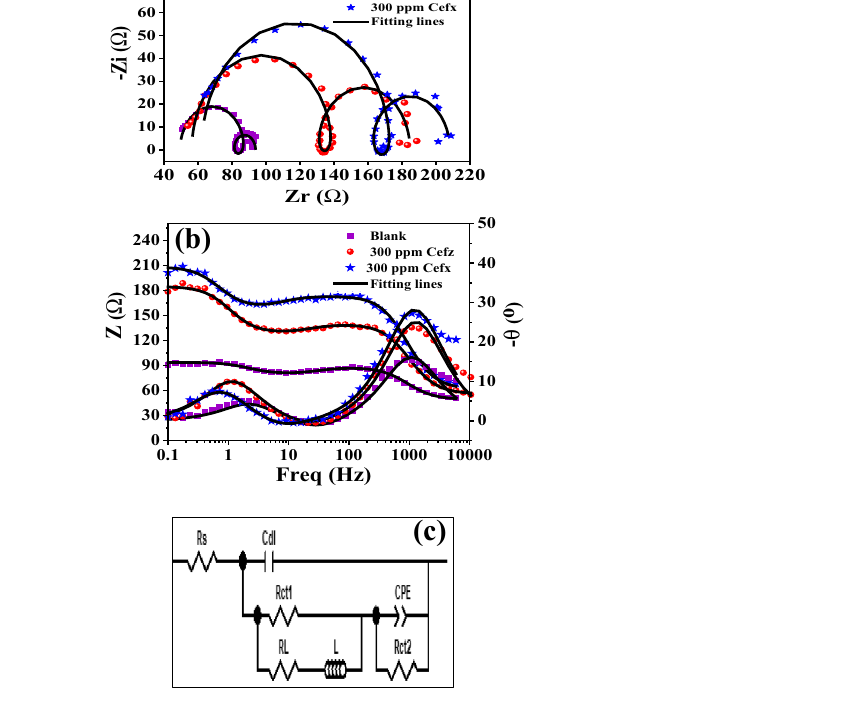
Figure 7. Electrochemical impedance spectroscopy measurements of Al in 0.1 M NaOH solution at E OCP in the absence and presence of 300 ppm of Cefx and Cefz at 293 K, ( a ) Nyquist plots, ( b ) Bode plots and ( c ) electrochemical equivalent circuit (EC 1